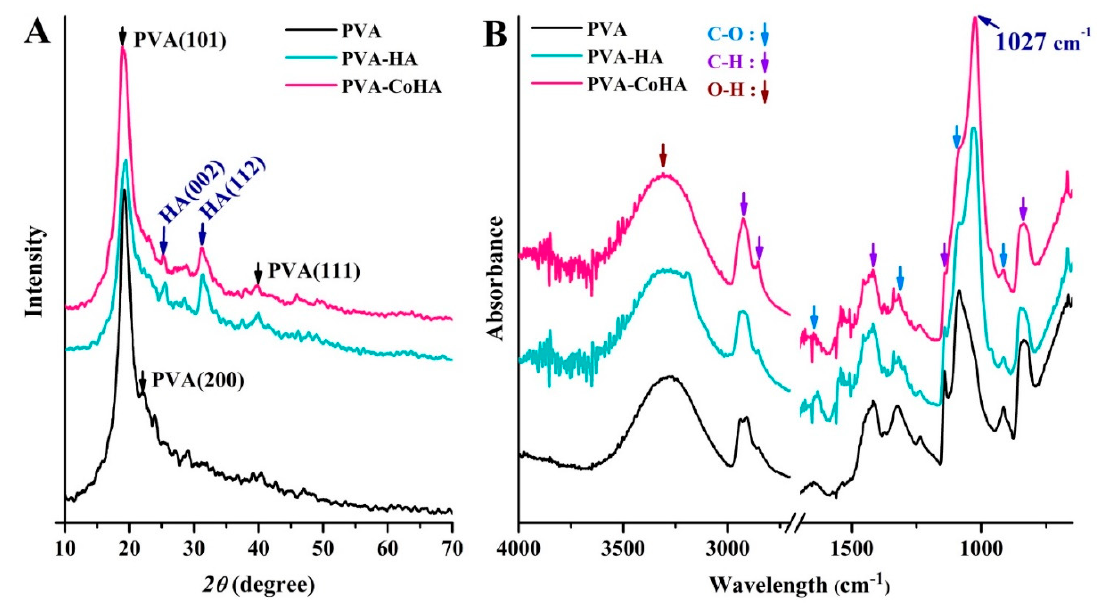
Figure 6. ( A ) XRD patterns and ( B ) ATR-FTIR spectra of PVA and PVA-CoHA nanocomposites after immersion in SBF for 7 days.